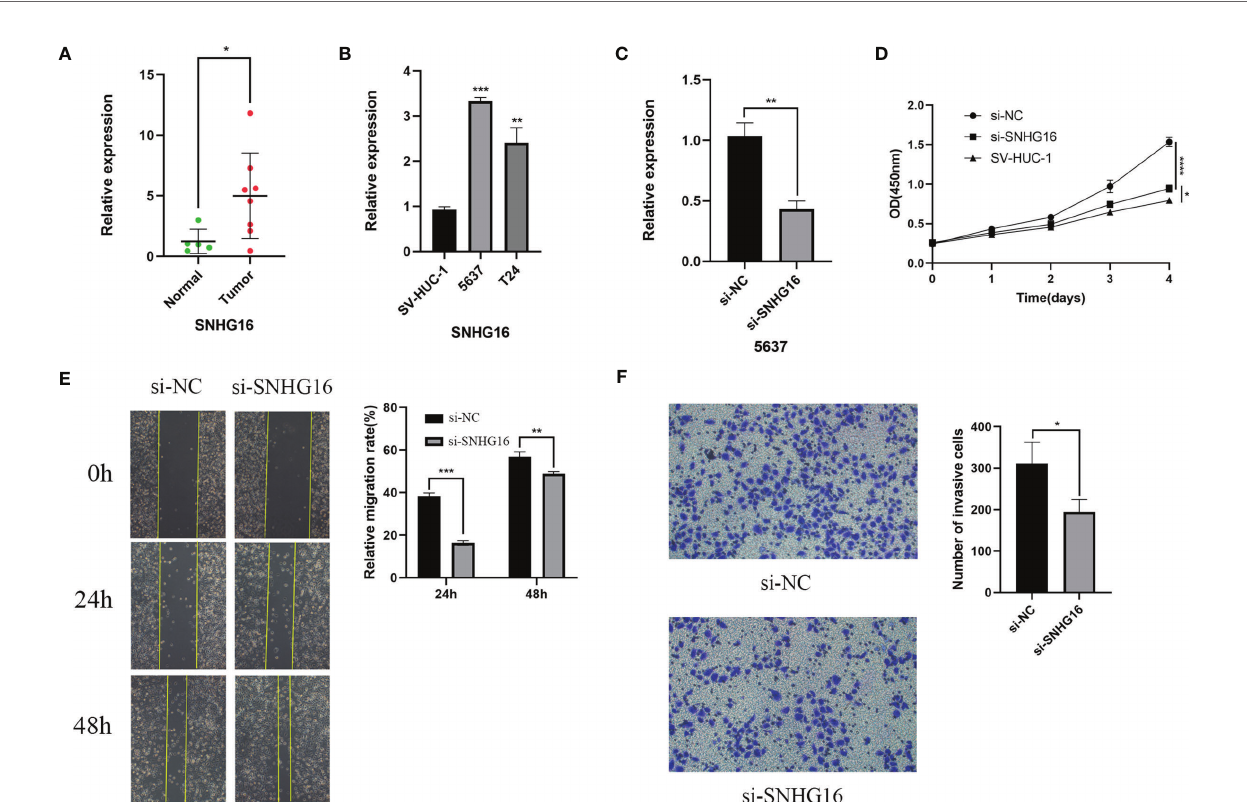
FIGURE 10 | SNHG16 was highly expressed in BC tissues and cell lines and interfered with siRNA resulted in suppressed proliferation, migration, and invasion in vitro . (A) The SNHG16 expression in BC tissues and paracancerous tissues. (B) SNHG16 expression level was assessed in the immortalized human bladder epithelial cell line SV-HUC-1 and the BC cell lines 5637 and T24 by qPCR. (C) The ef fi ciency of siRNA knockdown of SNHG16 was assessed in the BC cell line 5637 by qPCR. (D) Cell proliferation was determined in SV-HUC-1 cells and 5637 cells transfected with si-SNHG16 or si-NC by CCK-8 assay on days 0, 1, 2, 3, and 4. (E) Scratch wound assay: The scratch was imaged after transfection, and cell mobility was measured by determining the extent of wound closure at 24 and 48 h (× 100). (F) The invasion of 5637 cells transfected with si-SNHG16 or si-NC was evaluated by transwell assay with Matrigel (× 200). * P <0.05, ** P <0.01, *** P <0.001, and **** P